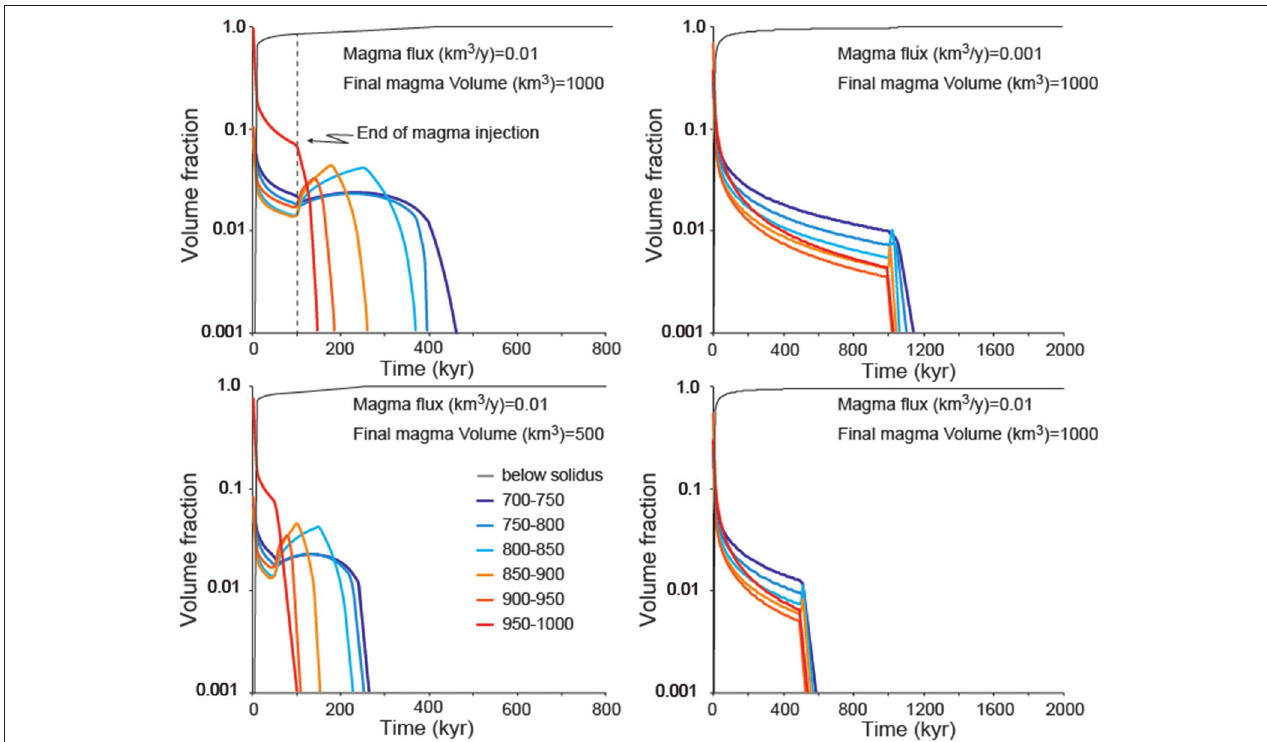
FIGURE 2 | Temporal evolution of the volume fraction of magma within different temperature intervals (colored lines). The black line shows the fraction of magma at temperature lower than the solidus (700 ◦ C).